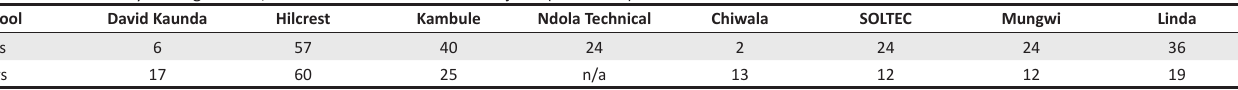
TABLE 7: Girls and boys taking science, mathematics and technical subjects (combined). School